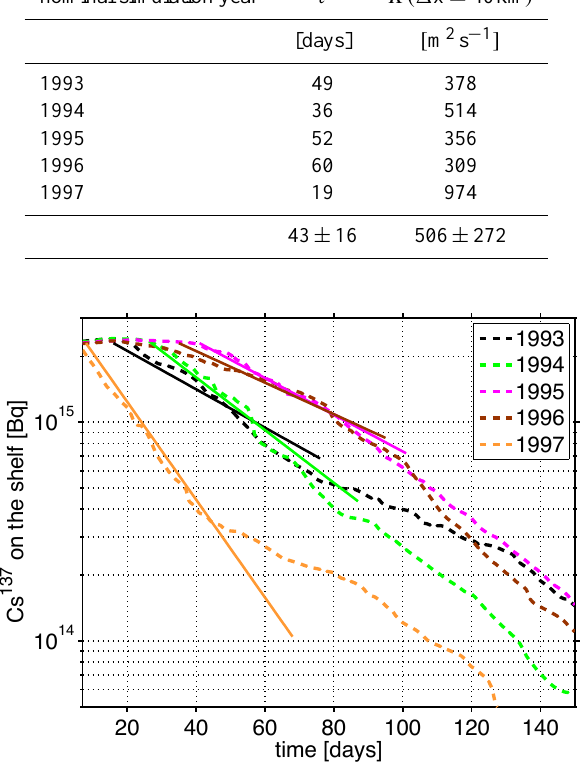
Fig. 15. Decline of the simulated 137 Cs inventories on the shelf (dashed lines). The time axis corresponds to days elapsed since the 137 Cs was released in the nominal years indicated by the figure leg- end. The solid lines are least square fits to Eq.